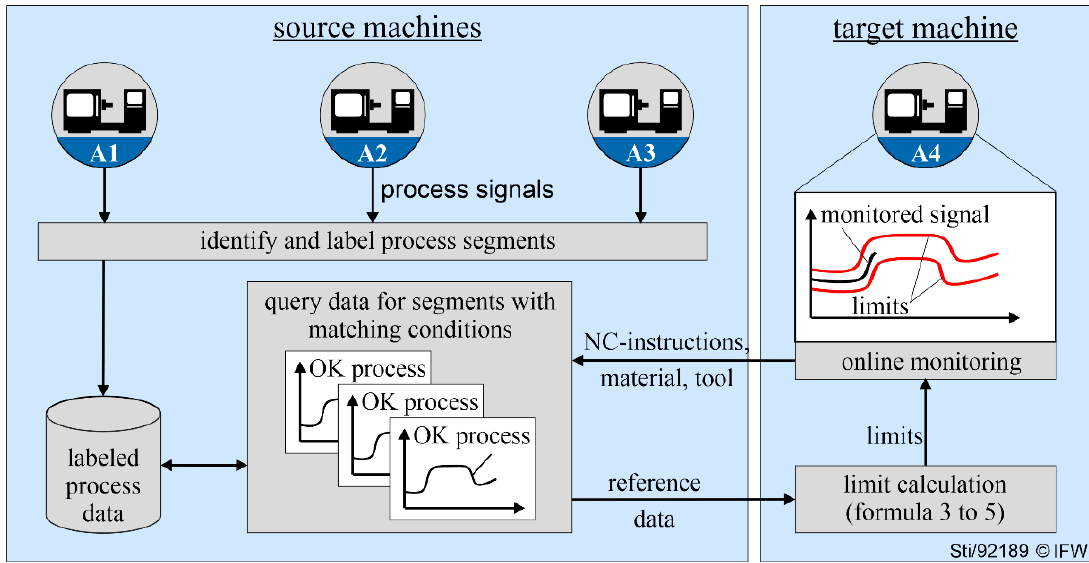
Figure 2. Scheme for online monitoring with transferred knowledge.